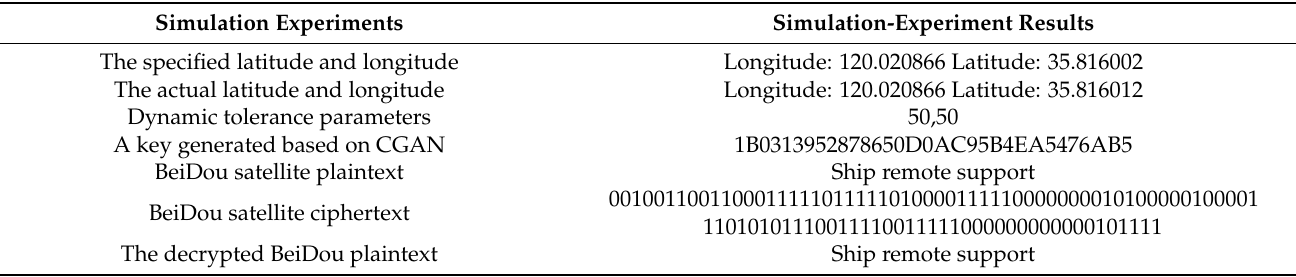
Table 3. Encrypted-communication test